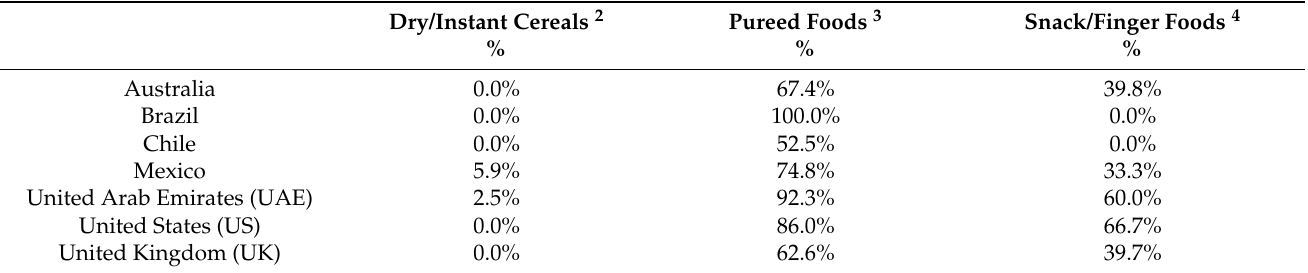
Table 4. Proportion of commercially produced complementary foods warranting a WHO Europe high sugar front-of-pack warning, by product category 1